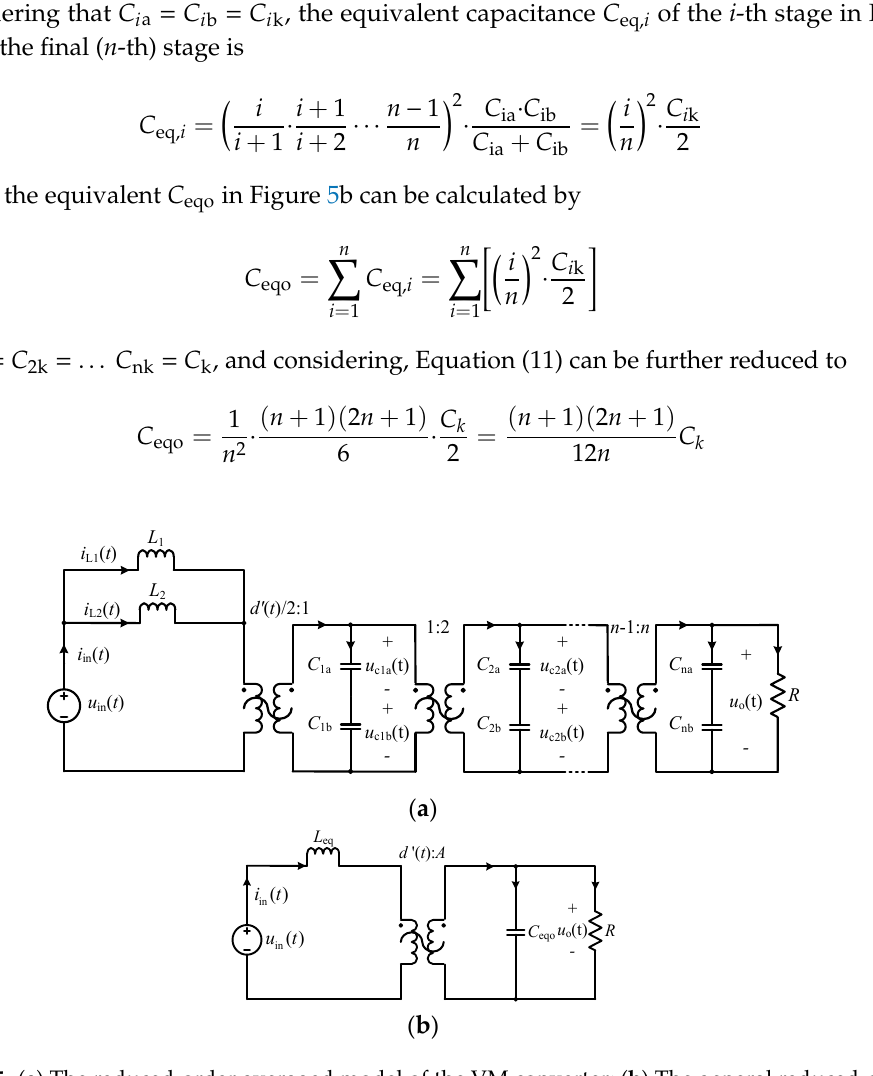
Figure 5. ( a ) The reduced-order averaged model of the VM converter; ( b ) The general reduced-order averaged model of the converters based on VM.